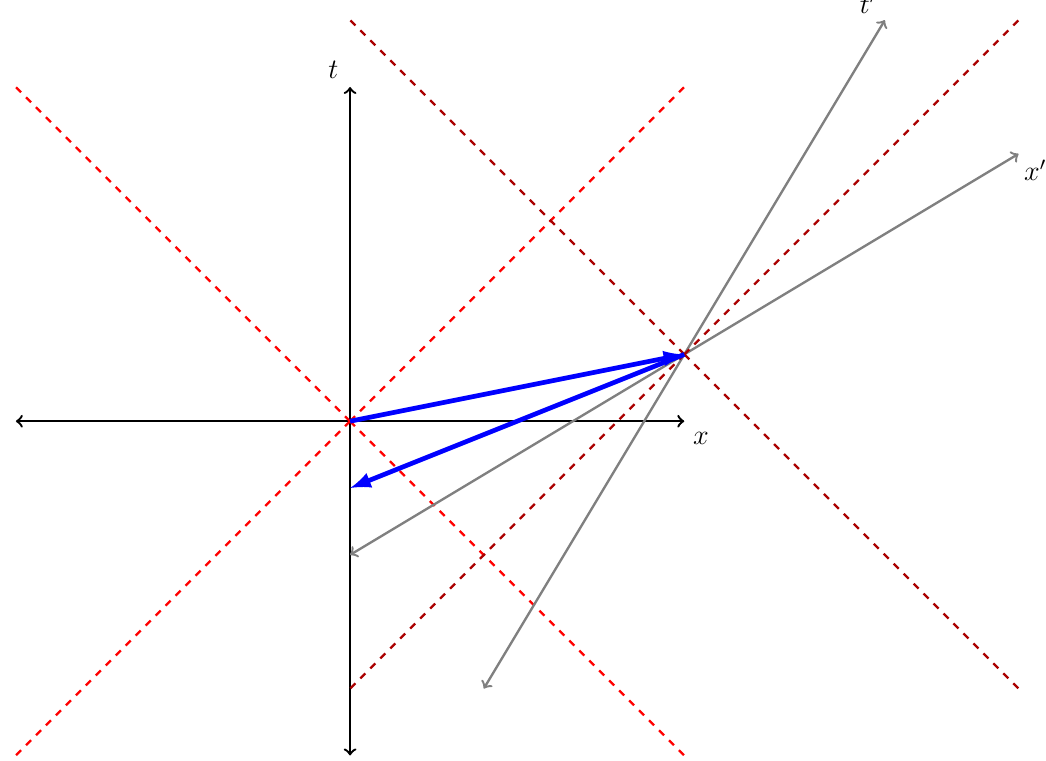
Figure 1: Using tachyons to send a message back in time. The black lines are the axes for the ( t , x ) system, the gray lines are the axes for the lines are the light cones for the ( t , x ) system, the dark red lines are the light cones for (cid:0) (cid:1) t (cid:48) , x (cid:48) the system, and the blue lines are the (spacelike) worldlines of the